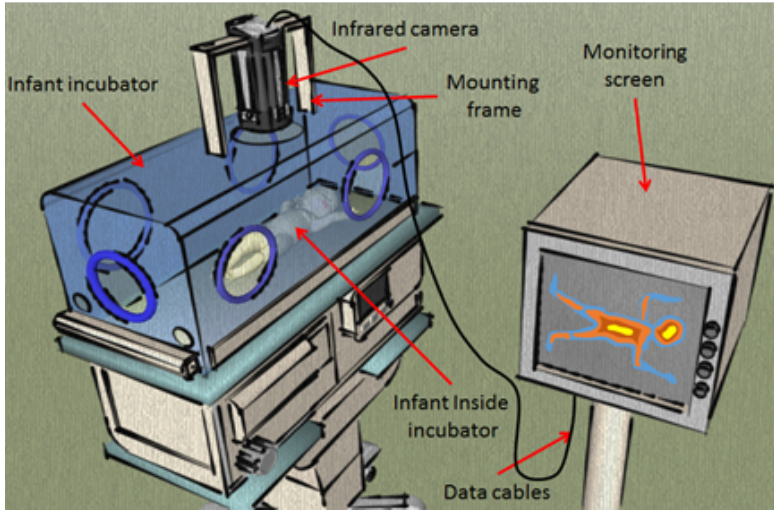
Figure 2. First contactless imaging setup used by Clark in 1980. This setup uses a traditional infrared camera with five frames per second (fps) and 5 ◦ C